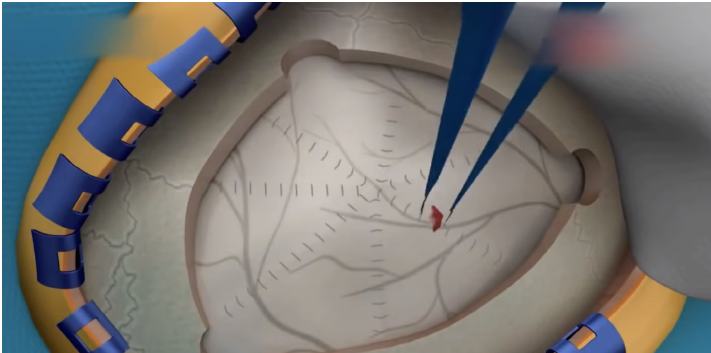
Figure 7. Three-dimensional scalar field visualization. The image shows a screenshot of the suture after resection of the tumor during 3D tumor resection.